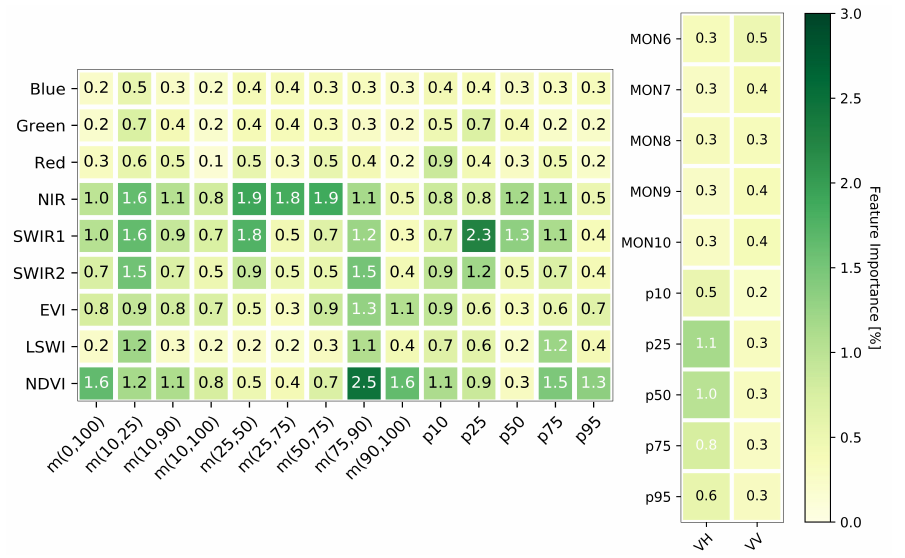
Figure 12. Importance of the features generated in the RF classifier indicating an error increase for ‘out-of-bag’ (OOB) samples when a feature was removed. Here, the RF classifier was applied in the Scikit-learn package of Python [70]. The importance value was averaged for 10 cross-validations. The normalized differenced vegetation index (NDVI) interval mean value between the 75 th and 90 th percentiles was the most important feature, and the NIR was the foremost band, with an overall importance of